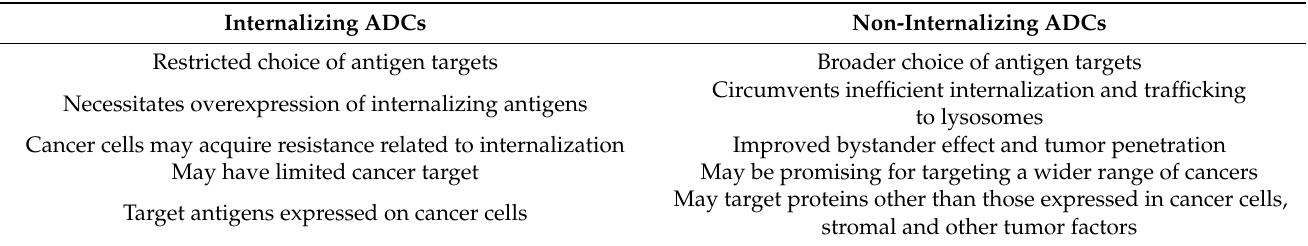
Table 2. The pros and cons of internalizing and non-internalizing